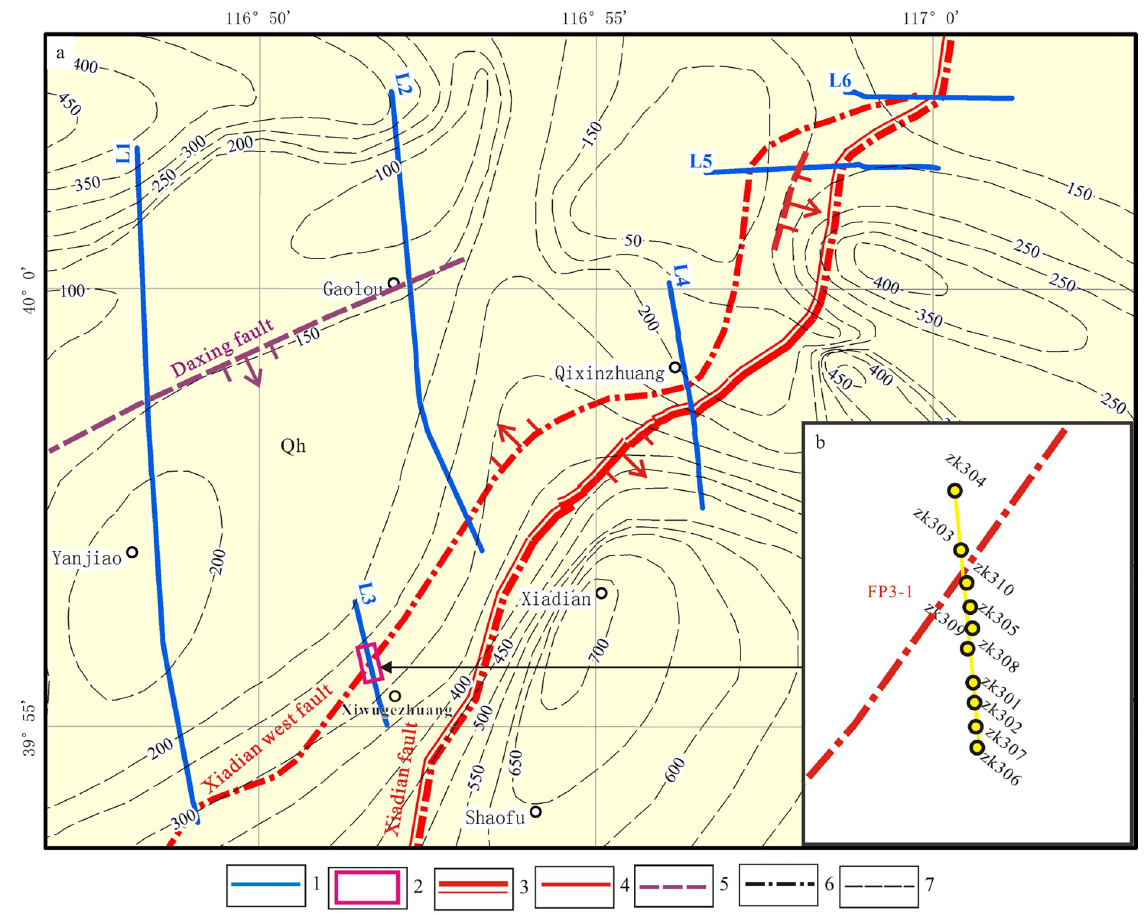
Fig 3. Location of shallow seismic exploration line and joint drilling profile detection(a) and borehole distribution of joint drilling profile detection (b). The Quaternary thickness contour is adapted from Deng et al. [4]. 1. Location and number of shallow seismic exploration lines; 2. Location of joint drilling profile; 3. Holocene fault; 4. Late Pleistocene fault; 5. Buried fault; 6. Surface fault; 7. Quaternary thickness contour.